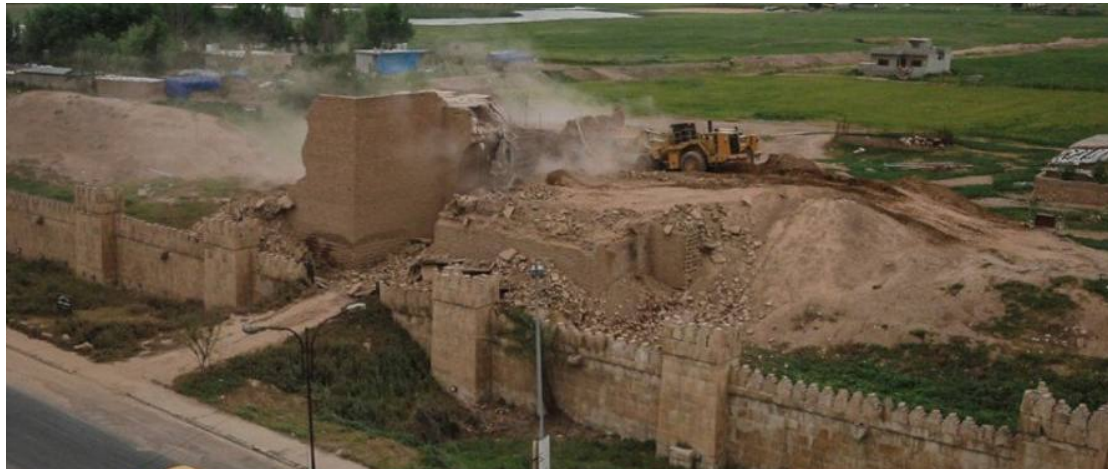
Figure 33. Frame of a video reporting Mashki Gate destruction (April 2016)